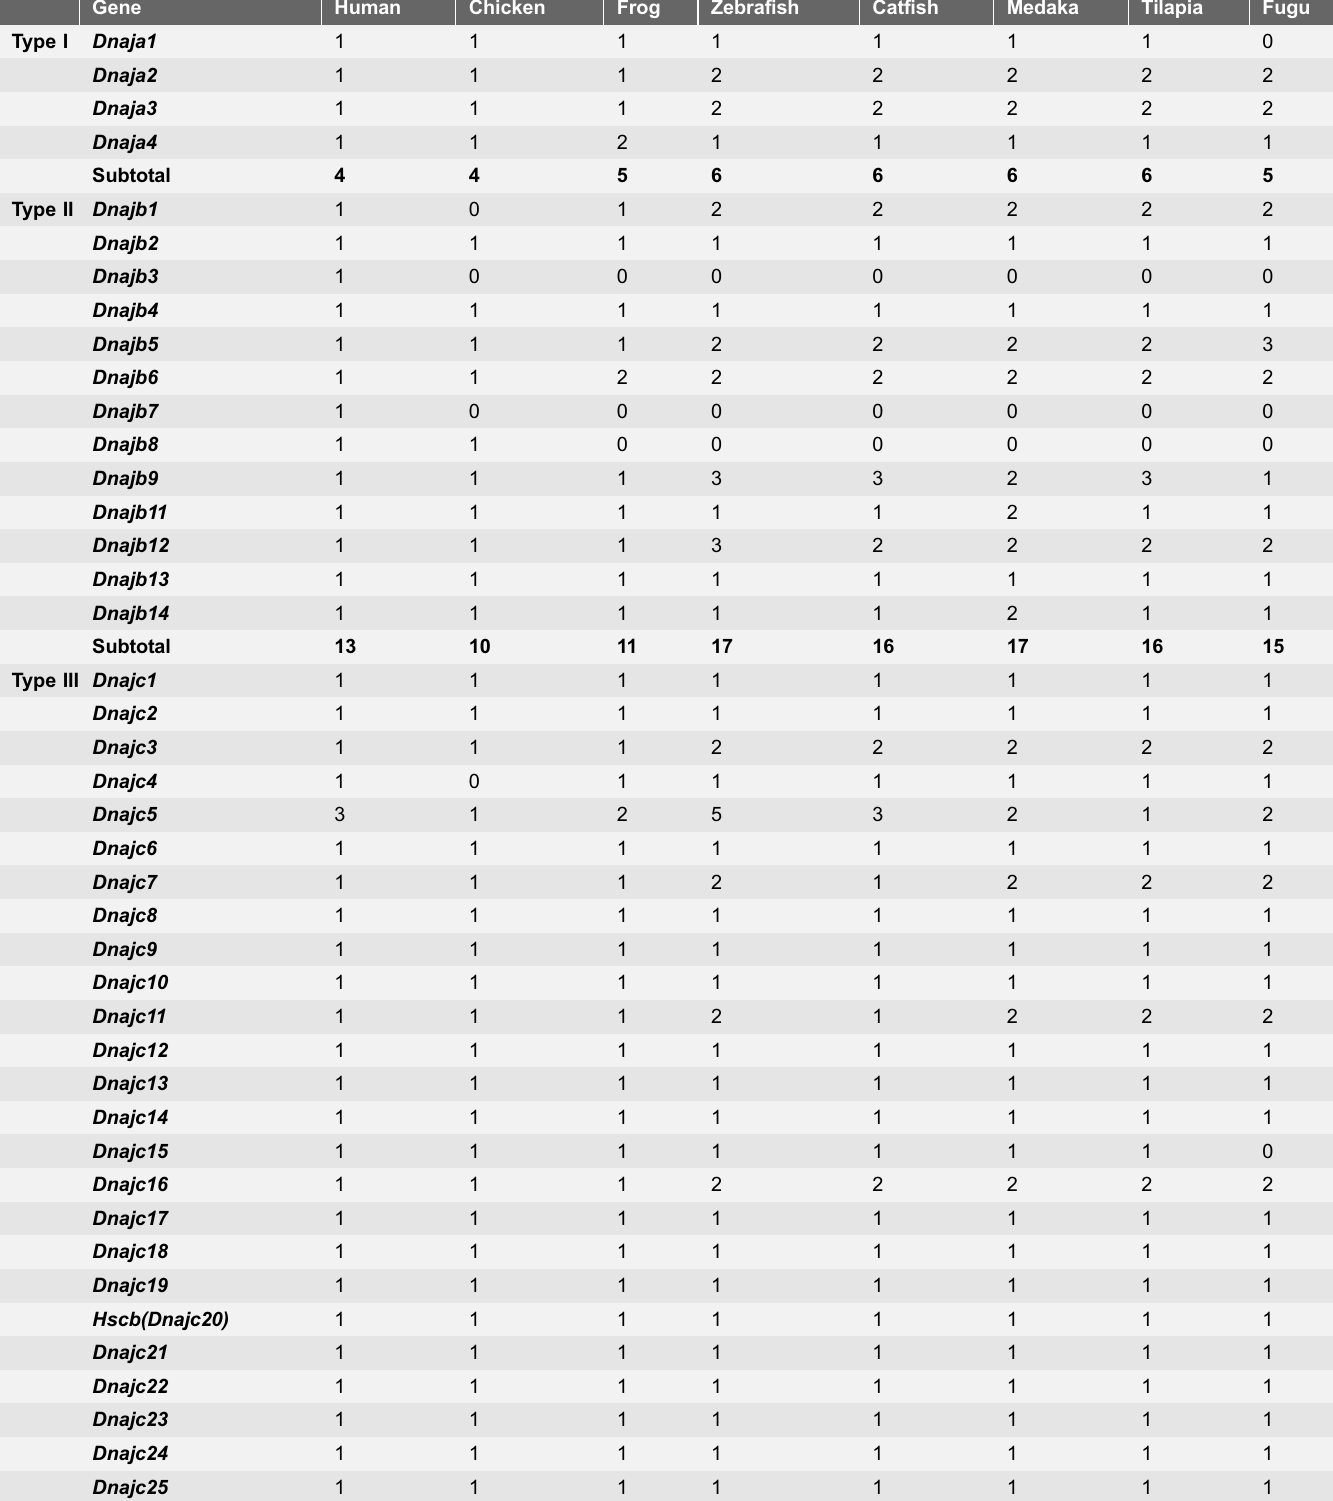
Table 2. Comparison of copy numbers of HSP40 genes among selected vertebrate